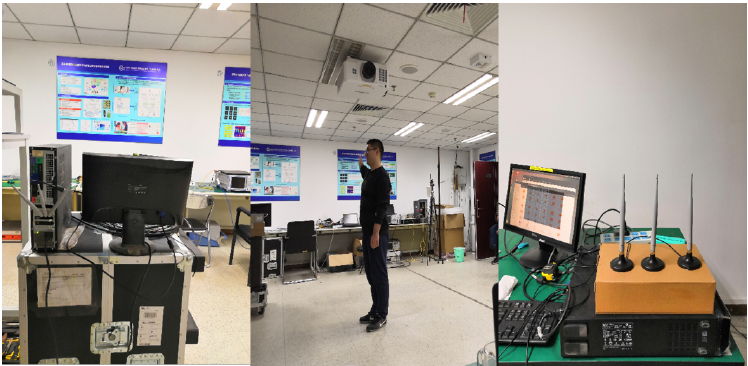
Figure 1. Data collection experimental scene in the office.